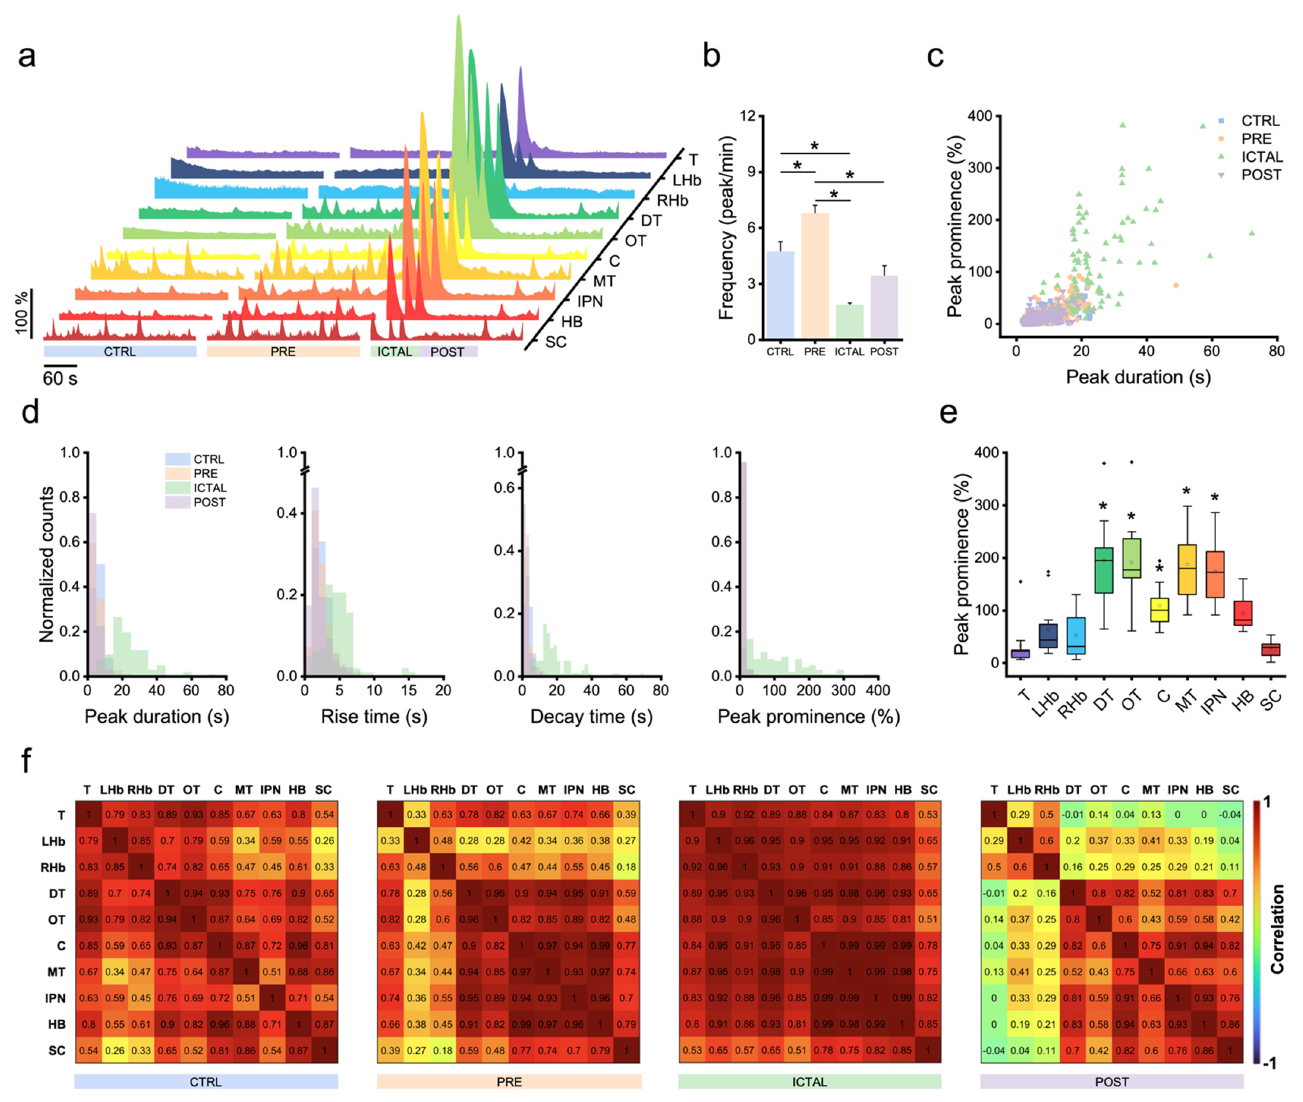
Figure 2. Zebrafish brain undergoes transition between different activity regimes during seizures. ( a ) ∆ F/F 0 traces of the ten larval brain regions (colored as in Figure 1a) during four diverse activity regimes observed at maximal PTZ concentration (15 mM). CTRL (pre-exposure), PRE (preictal), IC- TAL and POST (postictal). ( b ) Average frequency of activity peaks in the different regimes pre- sented in panel ( a ). * indicates p -value < 0.05 for inter-regime comparison, one-way repeated measures ANOVA and post hoc Tukey’s test (for p -values see Table S3). Values represent mean ± s.e.m of n = 3 larvae per concentration. ( c ) Scatter plot showing peak duration as a function of peak prominence for each of the four regimes. ( d ) Normalized distributions of calcium transients’ kinetic features (peak duration, rise time, decay time and prominence) in each of the four activity regimes. For each parameter, all four distributions appear significantly different (two-samples K-S test with Bonferroni correction, α = 0.00833), except for peak prominence of CTRL vs. PRE and POST. For p - values, see Table S4. ( e ) Peak prominence during ictal regime for each of the ten brain regions. * indicates p -value < 0.00111 for inter-region comparison with telencephalon, two-samples K-S test with Bonferroni correction, α = 0.00111 (for p -values see Table S5). Box: IQR; error bar: 1.5 IQR; black line: median; white square: mean; black diamond: outlier. ( f ) Correlation matrices reporting average pairwise Pearson’s correlation coefficients of neuronal activity during the four regimes across the ten brain regions. Finally, we investigated how the functional connectivity between brain regions is al- tered by the dimming effect that the convulsant exerts on inhibitory tone. While